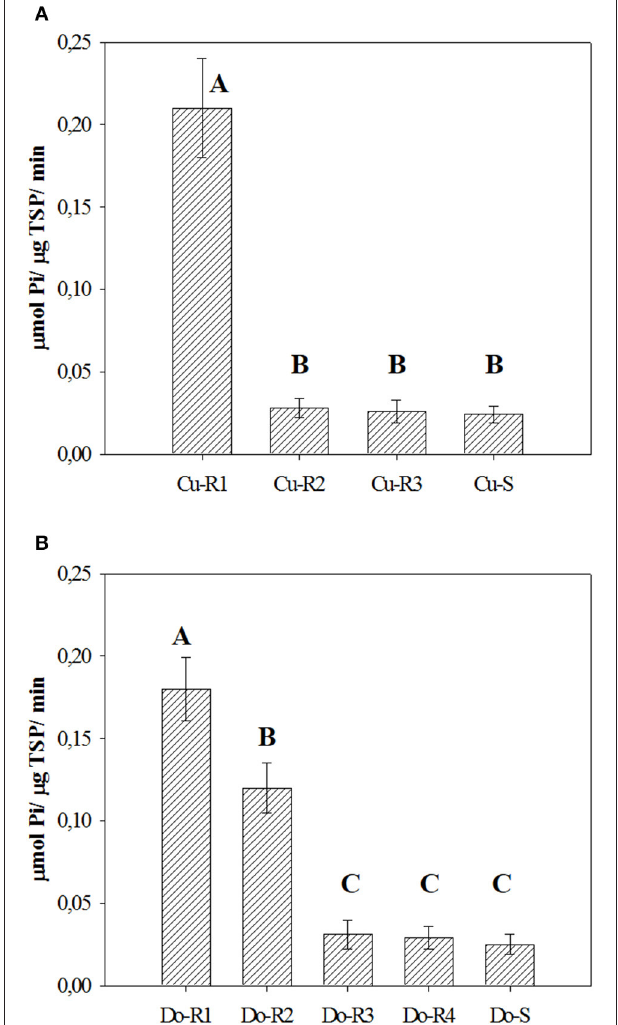
FIGURE 5 | Basal EPSPS activity for glyphosate-susceptible and resistant from Cuba (A) and Dominican Republic (B) accessions of P. hysterophorus . Vertical bars are ± standard errors of the mean. Means by the same letter were not significantly different at α =